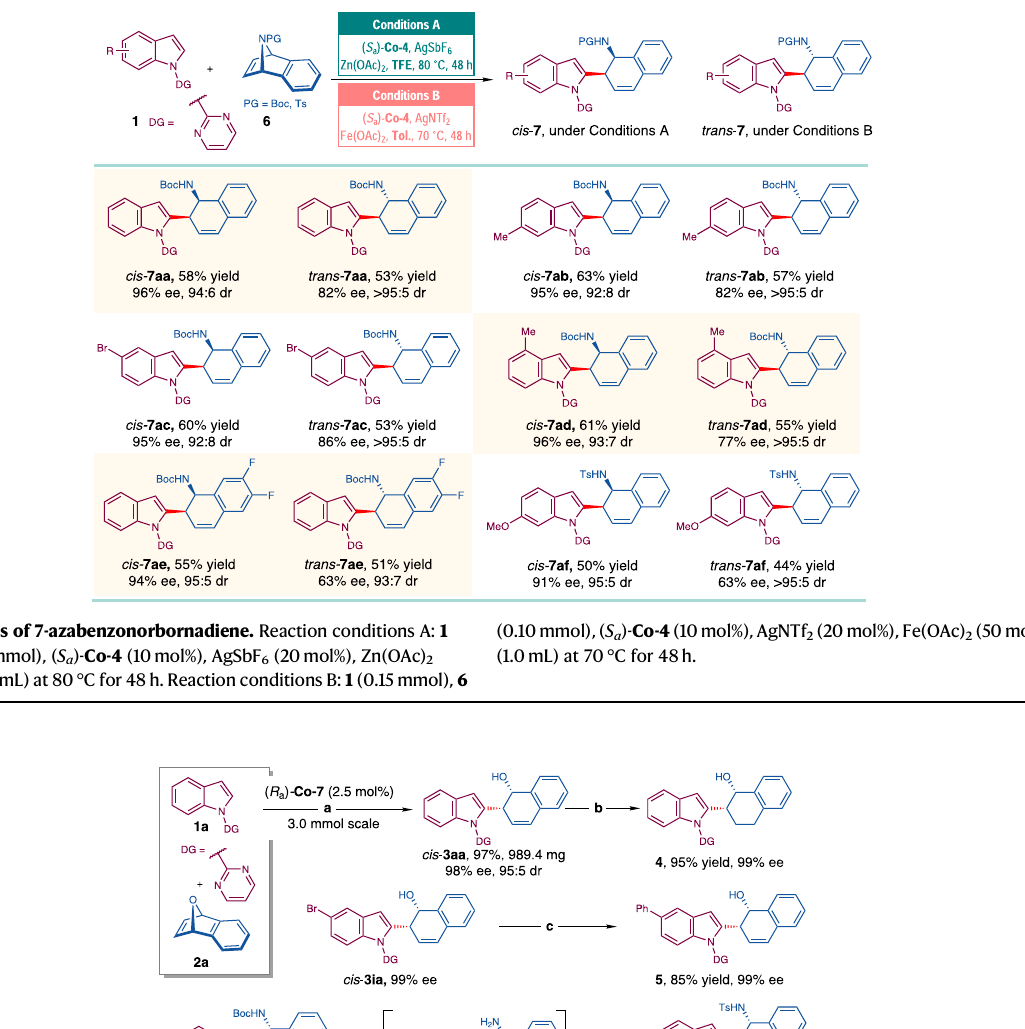
SPhos(10mol%),Na 2 CO 3 (0.5equiv),toluene/EtOH/H 2 O(1.25mL,v/v/v=3:1:1).(d) HCl(2.0mL, 4Mindioxane),rt.,overnight.(e)DMAP(1.0equiv),TsCl(1.2equiv), Et 3 N (6.0 equiv), DCM (2.0mL), rt., 12h.